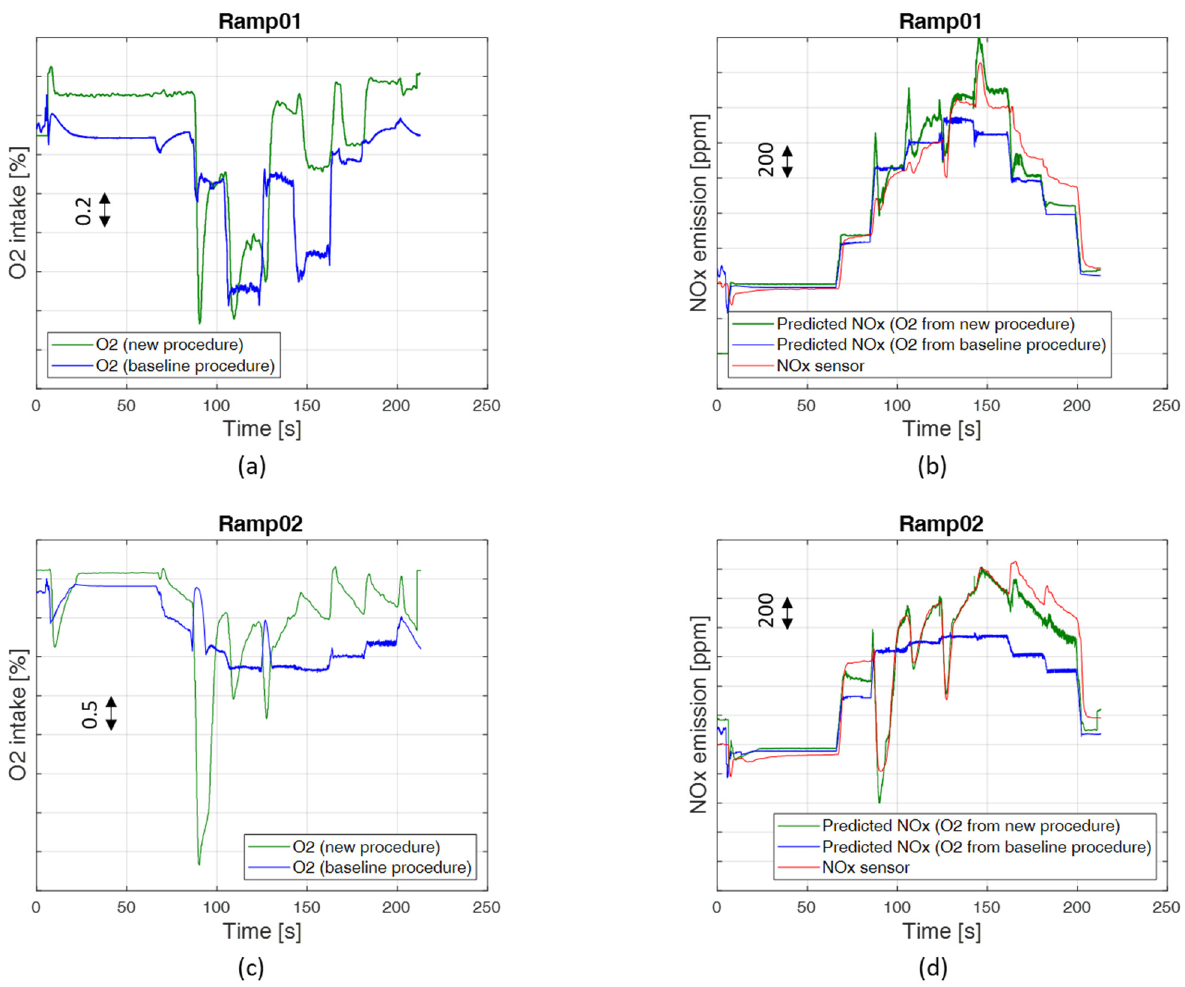
Figure 11. ( a , c ): Time histories of the ECU-derived intake O 2 concentration values (blue lines) and of the intake O 2 concentration values evaluated by means of the new procedure (green lines). ( b , d ): Time histories of the engine-out NOx values predicted by the combustion model using the intake O 2 concentration derived from the baseline ECU-derived procedure (blue line) and the intake O 2 concentration evaluated by the new procedure (green lines), together with the values of NOx emissions measured by the NOx sensor (red lines) for ramp tests 1 and 2.